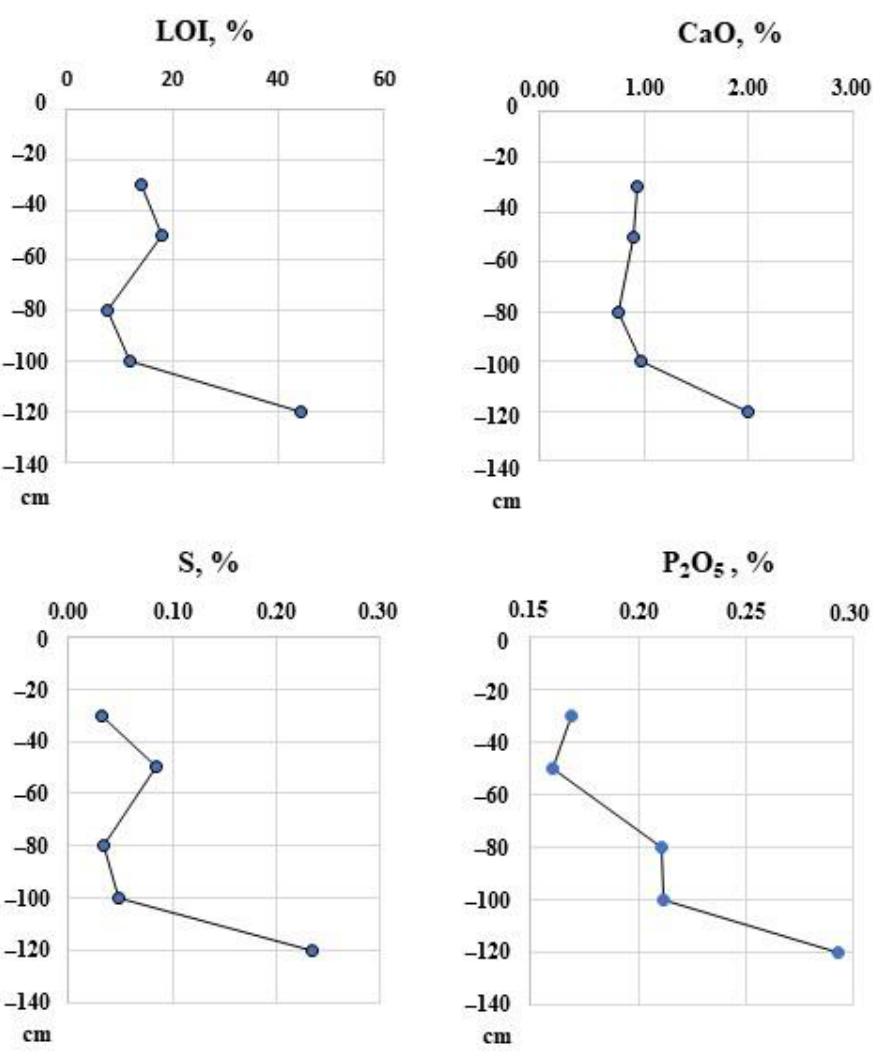
Figure 6. Loss on ignition (LOI); the content of calcium, sulfur, and phosphorus in the soil profile at palsa key site.